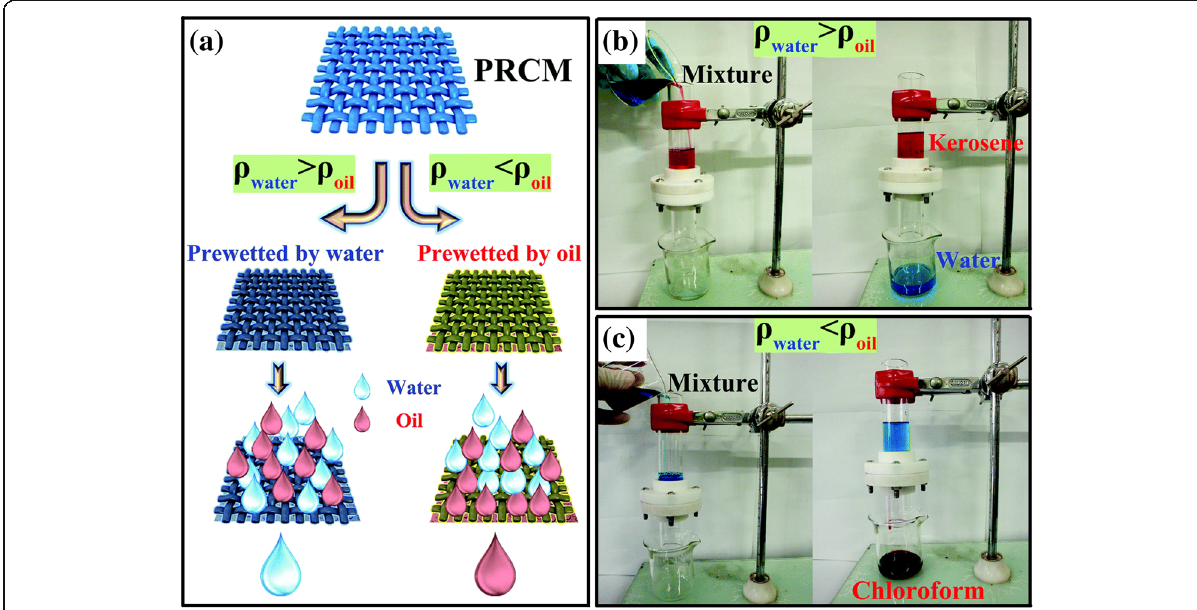
Fig. 12 a Schematic illustration of the selective separation of oil/water mixtures. PCRM means potato residue coated-mesh. b Separation of kerosene – water mixtures (where ρ wate r > ρ oil ). c Separation of chloroform – water mixtures (where ρ water < ρ oil ) (the water was dyed with methylene blue and oil is dyed with Oil Red O to enhance the visual effect)